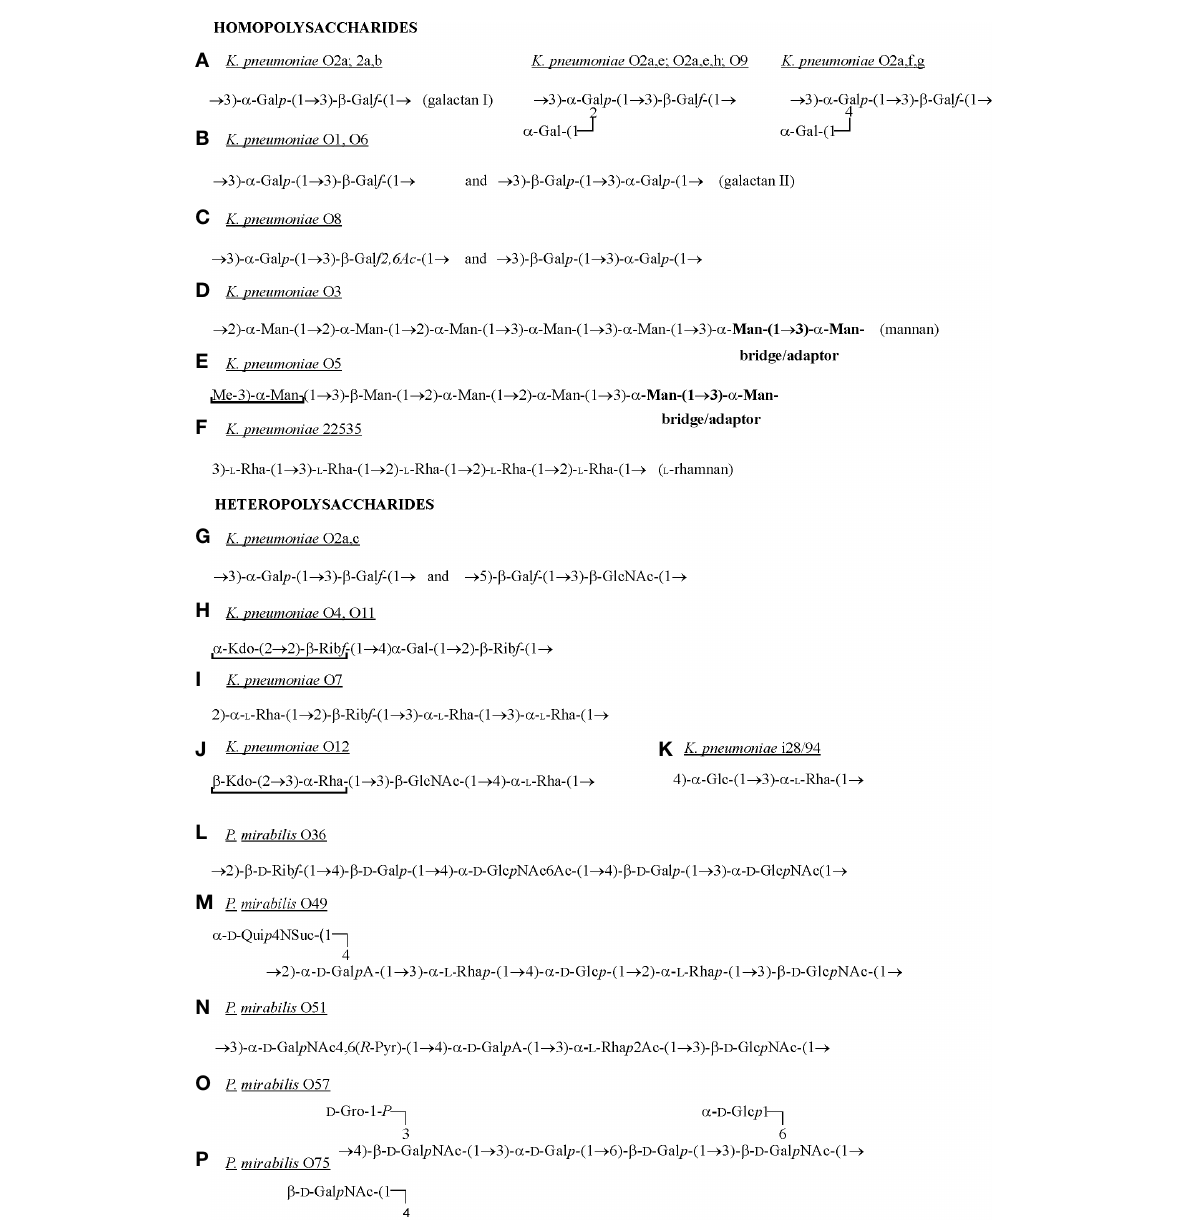
FIGURE 2 Structures of K. pneumoniae O-polysaccharides (A – K) and of those P. mirabilis OPSs (L-P) , which have the components common with the selected K. pneumoniae OPSs (Knirel, 2011; Knirel et al., 2011). The residues which do not belong to the repeating units are underlined. Gal f , galactofuranose; Gal p , galactopyranose; Glc, glucose; GlcNAc 2-acetamido-2-deoxy-D-galactose; GalA, galacturonic acid; D-GalNAc, 2- acetamido-2-deoxy-D-galactose; D-Gro-1- P , D-glycerol 1-phosphate; Kdo, 3-deoxy-D- manno -oct-2-ulosonic acid; Man, mannose; Pyr – pyruvic acid; Rha, ramnose; Rib f , ribofuranose; Suc, succinic acid; Qui4n,